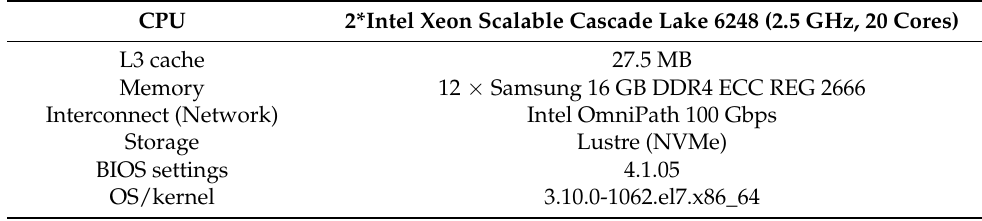
Table A1. Description of the parallel